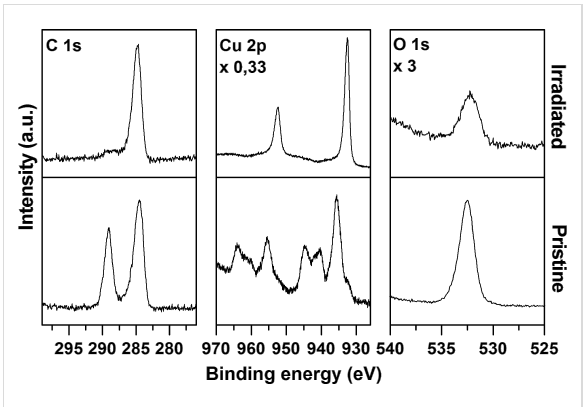
Figure 8: XP spectra in the ranges Cu 2p, O 1s, and C 1s recorded before (pristine) and after (irradiated) an electron exposure of 16000 μ C/cm 2 at 50 eV of surface grown copper(II) oxalate prepared by performing four deposition cycles. The sample was grown on a MUA-coated gold